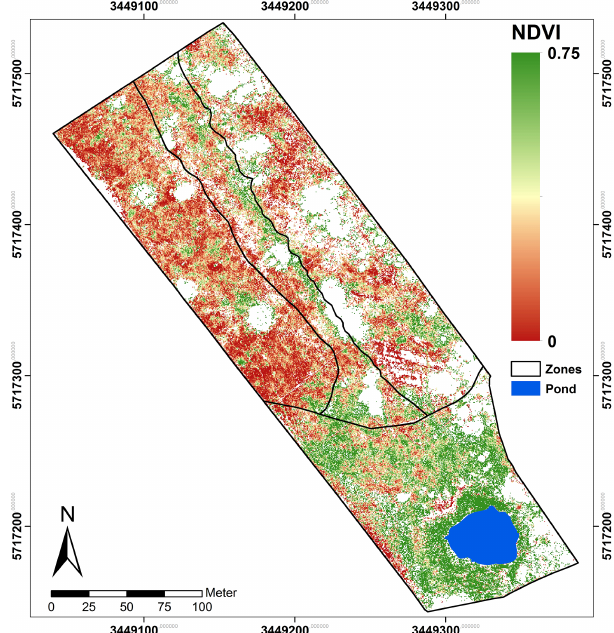
Figure 5. NDVI b 713 calculated from Eq. (1) using the red edge band. The area corresponds with the classified spread of C. epigejos (LCCs 1–4) and P. australis (LCCs